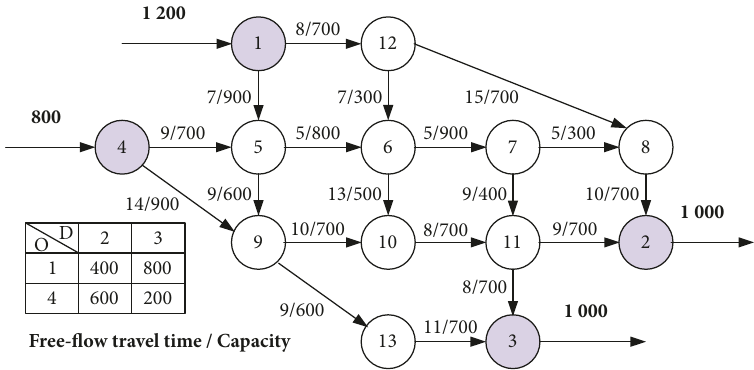
Figure 2: The Nguyen-Dupuis network with its OD pairs and capacities. Table 1: Free-flow travel time and capacities of the links in Nguyen-Dupuis